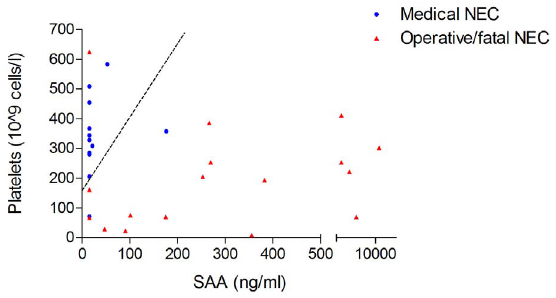
Figure 3. Combination of urinary SAA levels and platelet count in neonates with operative/fatal NEC (squares) and those with medically treated NEC (triangles) at diagnosis and one day prior to surgery in six neonates operated more than two days following diagnosis. The ideal cut-off line for differentiating between medical and operative/fatal NEC is depicted by the dotted